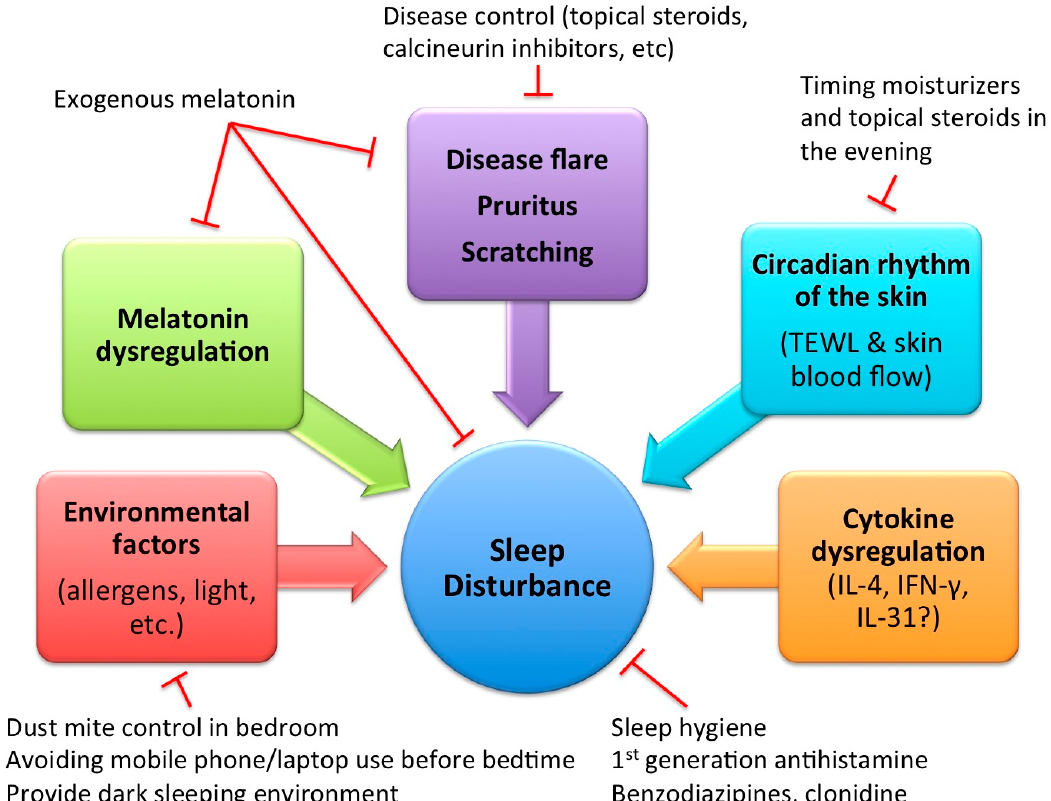
Figure 1. Mechanism of sleep disturbance in atopic dermatitis and possible treatment implications. T arrows indicate possible inhibitory effect with the suggested management options. TEWL: transepidermal water loss; IL-4: interleukin-4; IFN- γ : interferon- γ .